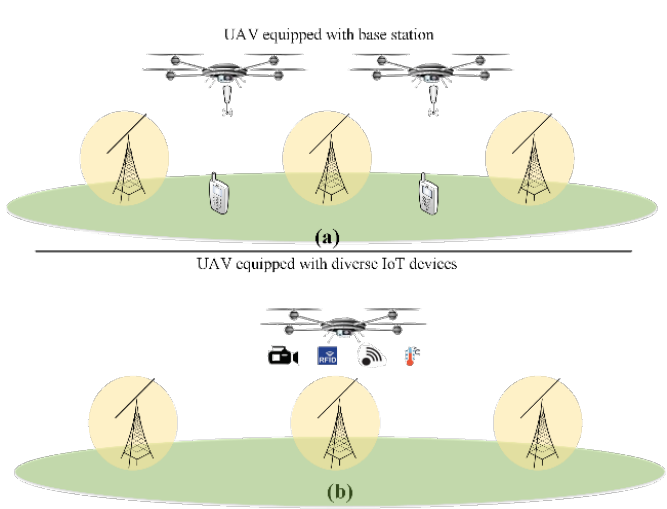
Figure 1. The role of UAVs (unmanned aerial vehicles) in a 5G-IoT (Internet of Things) scenario: ( a ) UAV equipped with base station; ( b ) UAV equipped with diverse IoT devices.